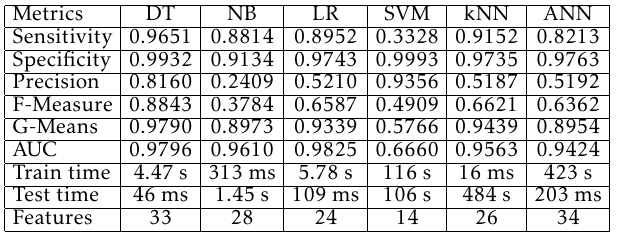
Table 11. Results of using IG-BFE algorithm on BACKDOOR. Metrics